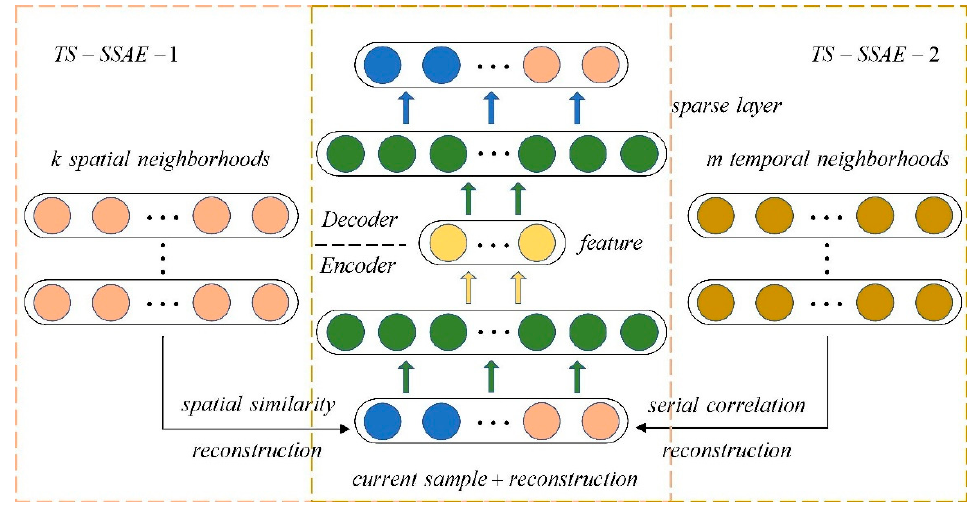
Figure 2. Structure of temporal-spatial neighborhood enhanced sparse stack autoencoder (TS-SSAE).